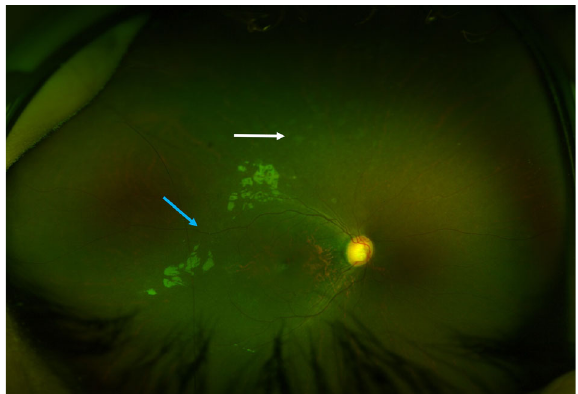
Fig. 3 Retinal features of Roifman syndrome in patient 1. Retinal exam featuring normal optic discs, dull foveal re fl ex, attenuated retinal vessels ( blue arrow ) and background retinal pigment epithelial changes in the middle and far periphery ( white arrow ).